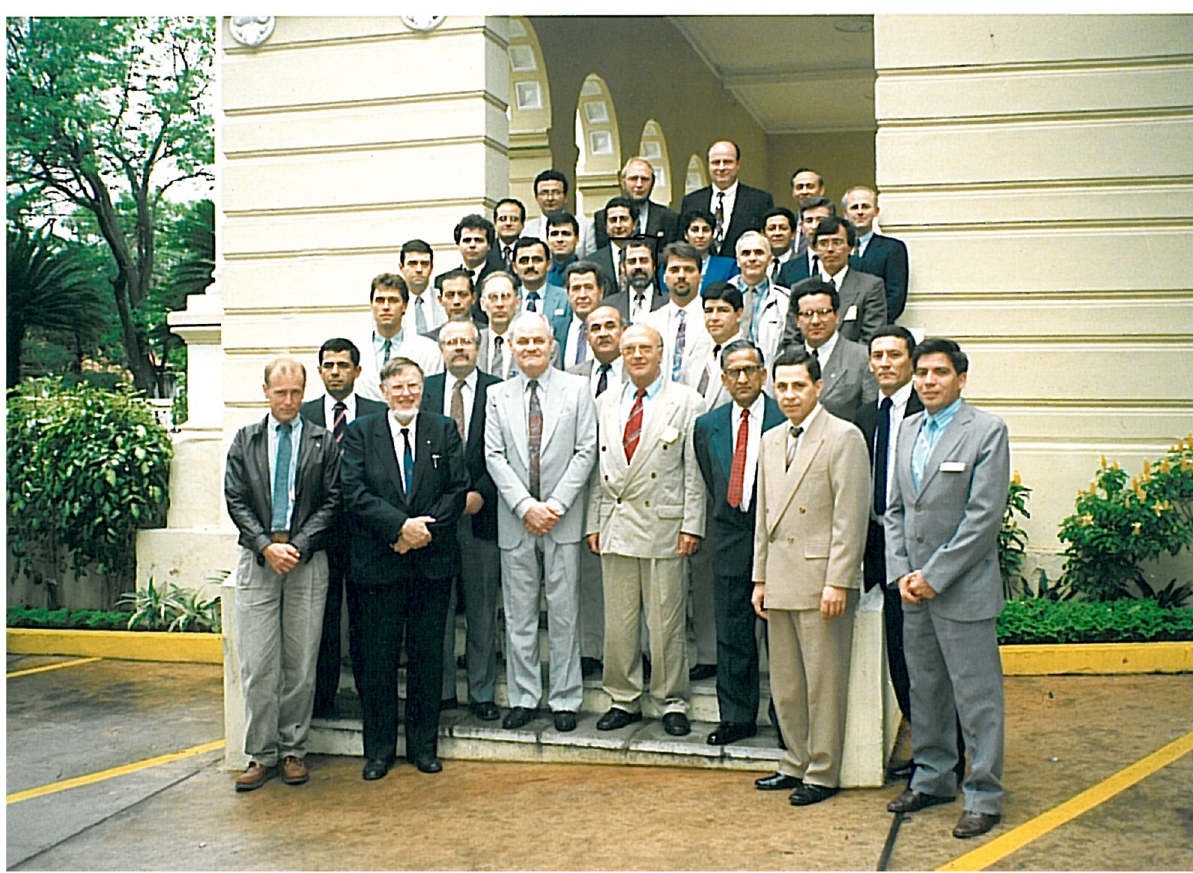
Figure 1: Participants of the conference “ Uni fi cation of the South American Datum ” , Asunción, Paraguay, October 4 – 7,